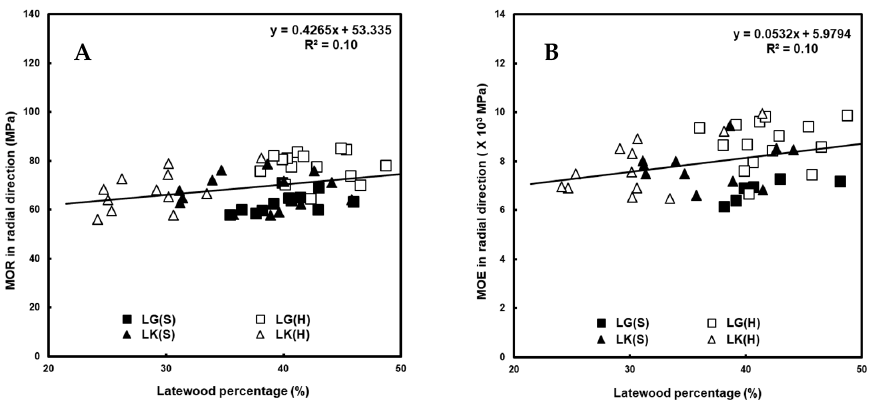
Figure 1. Relationship between growth ring width and bending properties in the radial ( A , B ) and tangential directions ( C , D ) of the sample species. LG: Larix gmelinii ; LK: Larix kaempferi ; S: Sapwood; H: Heartwood.